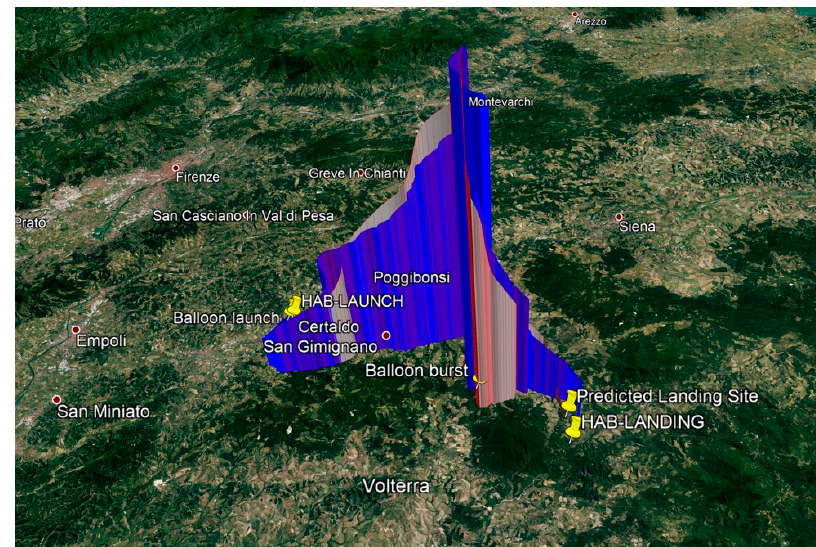
Figure 9. Simulated trajectory (red) vs. real trajectory (blue).